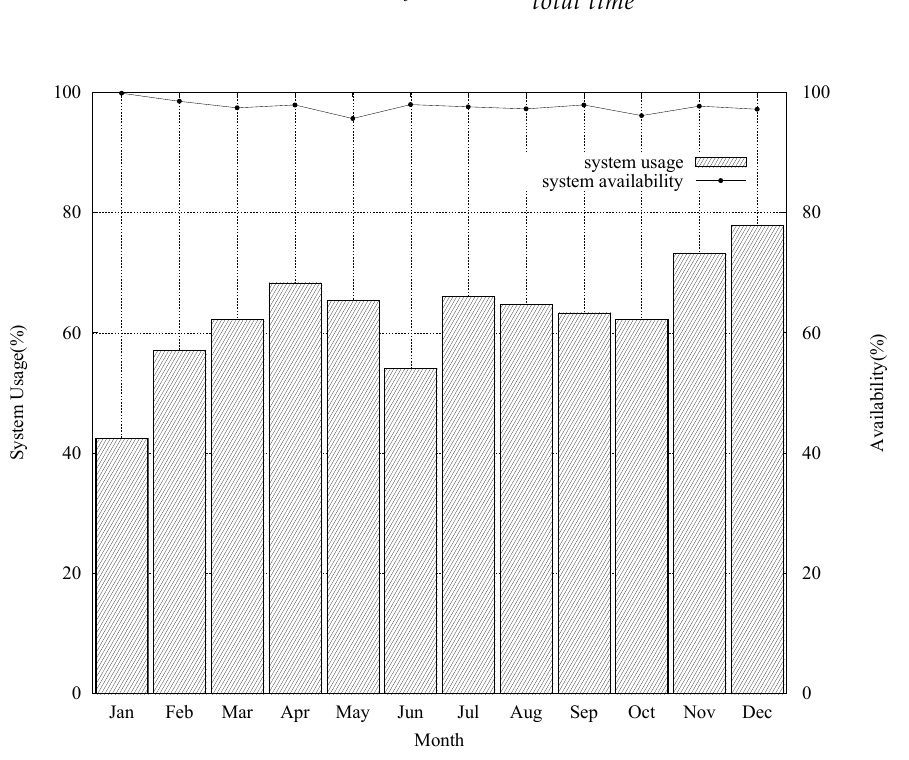
Figure 7. Utilization (bar graph, left y -axis) and availability (line graph, right y -axis) rates of the Nurion system in 2019.